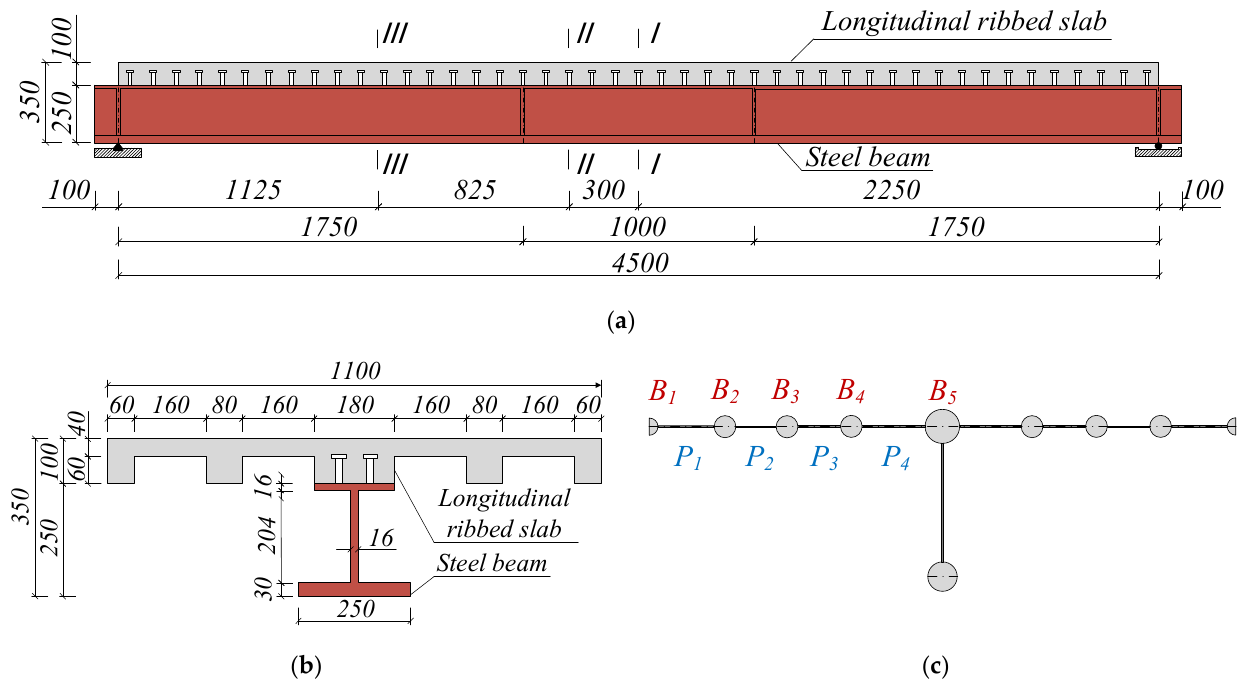
Longitudinal ribbed slab Steel beam SupportSupport Figure 9. Finite element model. The FEM is verified by the load-deflection relationships between the experimental test and the numerical results as shown in Figure 10. Figure 10. Load–deflection curve [26]. 0.0 0.5 1.0 1.5 2.0 2.5 3.0 3.5 4.0 4.50 255075100125150175200 L o a d / k N Deflection/mm experiment (Du T 2019) FEM